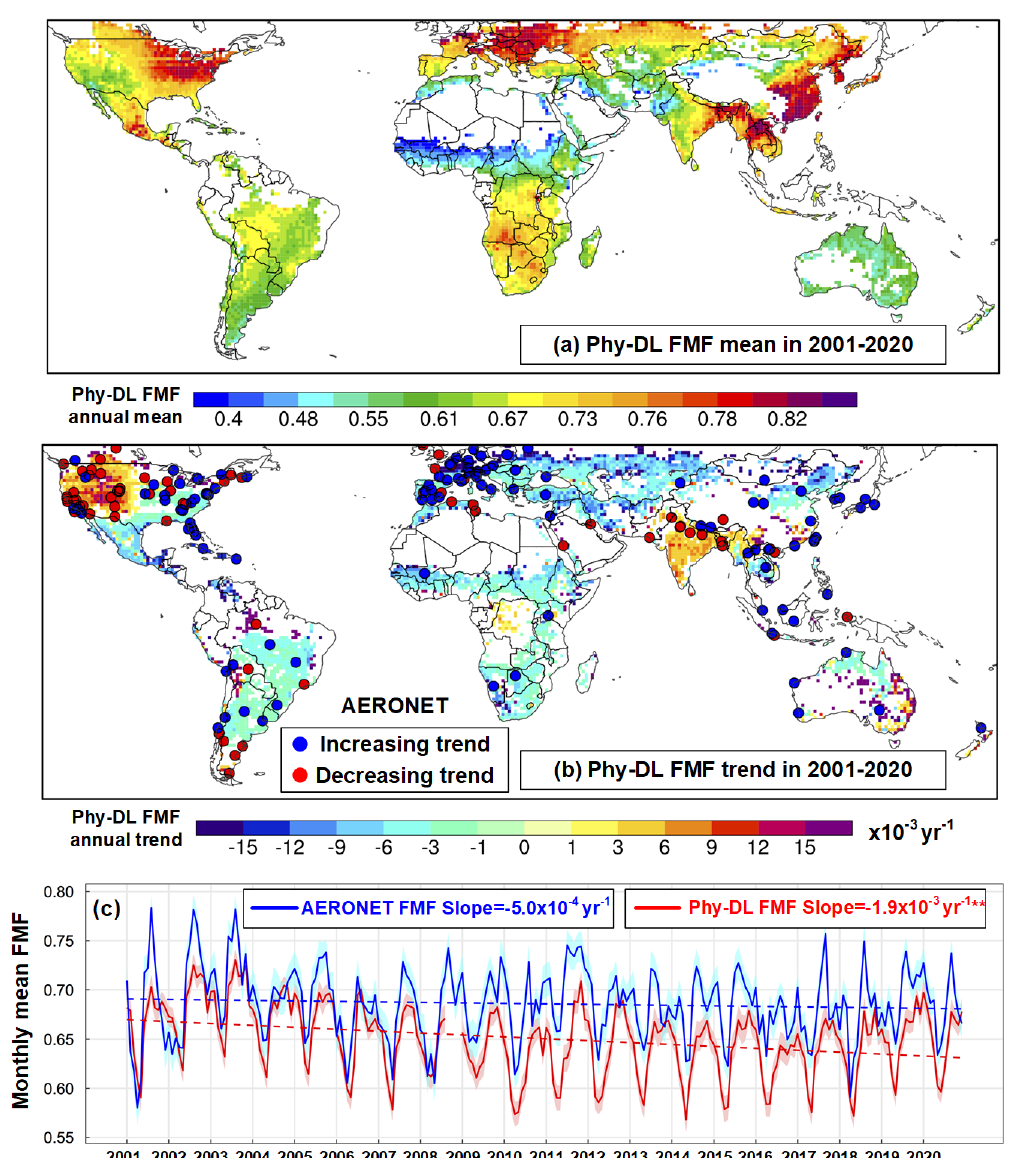
Figure 6. (a) Global distribution of Phy-DL FMF mean values over the 2001–2020 period. Only those pixels with over 120 retrievals per year were considered. (b) Global distribution of Phy-DL FMF linear trends from 2001 to 2020. Only those pixels with trends at the 95% significance level were considered. The red and blue dots represent AERONET stations with increasing and decreasing linear trends, respectively, at the 95% significance level. (c) Global monthly mean Phy-DL FMF (red line) and AERONET FMF (blue line). The shaded areas around each line represent the monthly mean FMF value ± 0.1 × the monthly standard deviation. The double-asterisks “ ∗∗ ” indicate that the linear trend was at the 95% significance